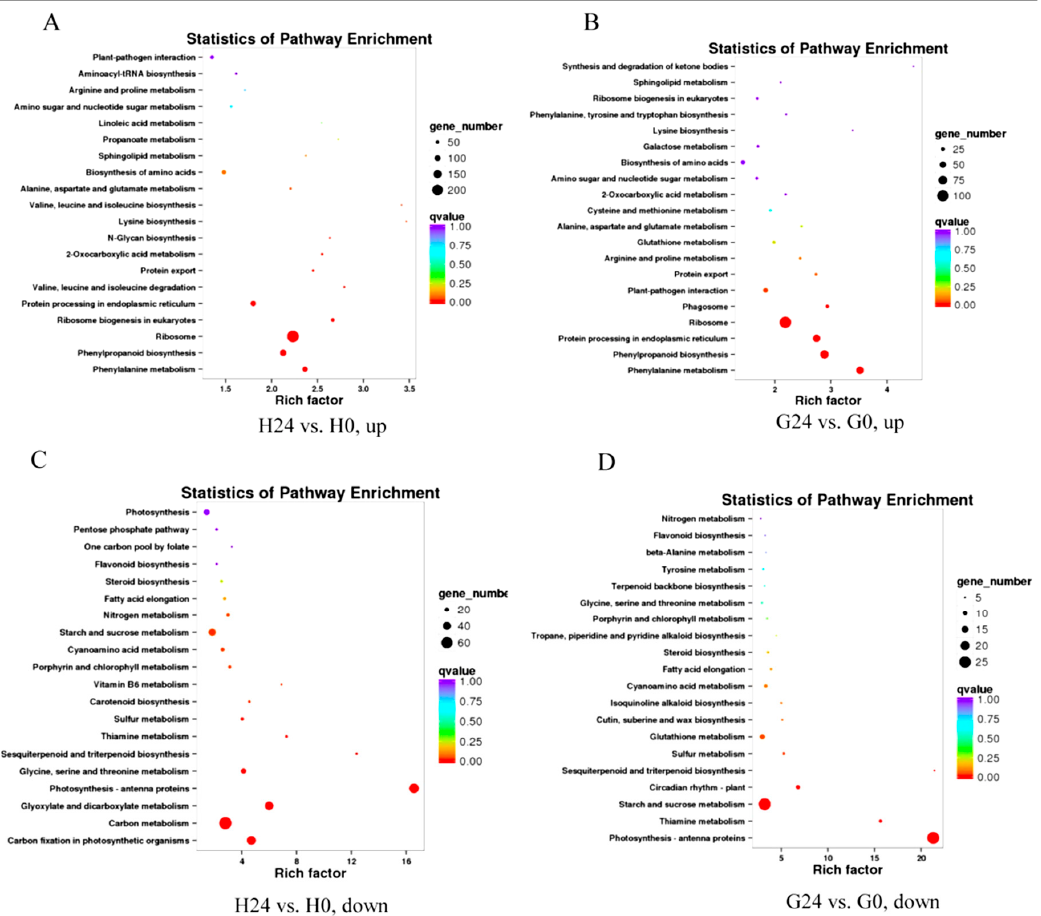
Figure 2. The top 20 enriched KEGG pathways of upregulated (in H24) DEGs in the ( A ) H24 vs. H0 and ( B ) G24 vs. G0 groups. The top 20 enriched KEGG pathways of downregulated DEGs (in H24) in the ( C ) H24 vs. H0 and ( D ) G24 vs. G0 groups. The color represents the Q-value as shown in the legend. Q-values are the p -values corrected for multiple hypothesis testing and range from 0 to 1. The closer the Q-value is to zero, the more significant the enrichment. The horizontal axis indicates the rich factor, which means that the ratio of the DEGs number and the number of genes are annotated in this pathway. The greater the rich factor, the greater degree of enrichment. The size of each circle indicates the number of DEGs in that pathway. The larger the circle, the greater number of DEGs.